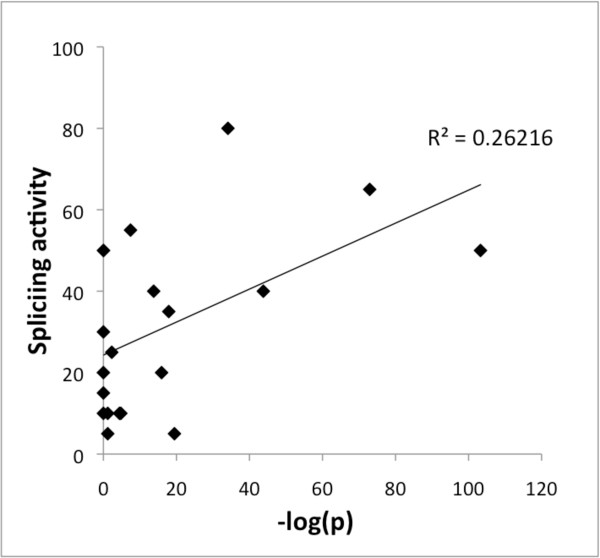
DCM p-values for motifs with known splicing activity. We observe a correlation between -log(p) for CodingMotif (DCM) p-values and experimentally measured splicing activity (as described in [3]) with r2 = 0.26 (t-test p-value 0.02).